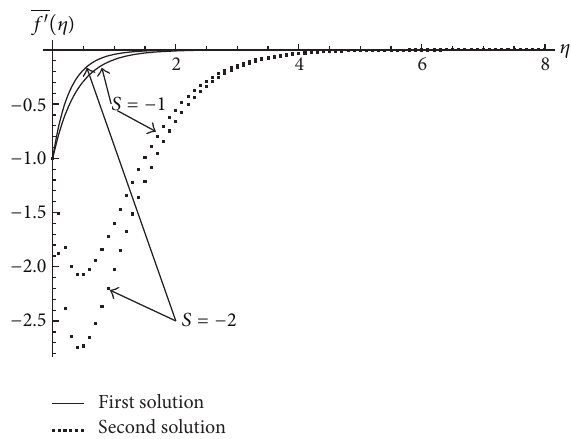
Figure 5: Velocity profile for different values of 𝑆 and 𝛾 = 2 .